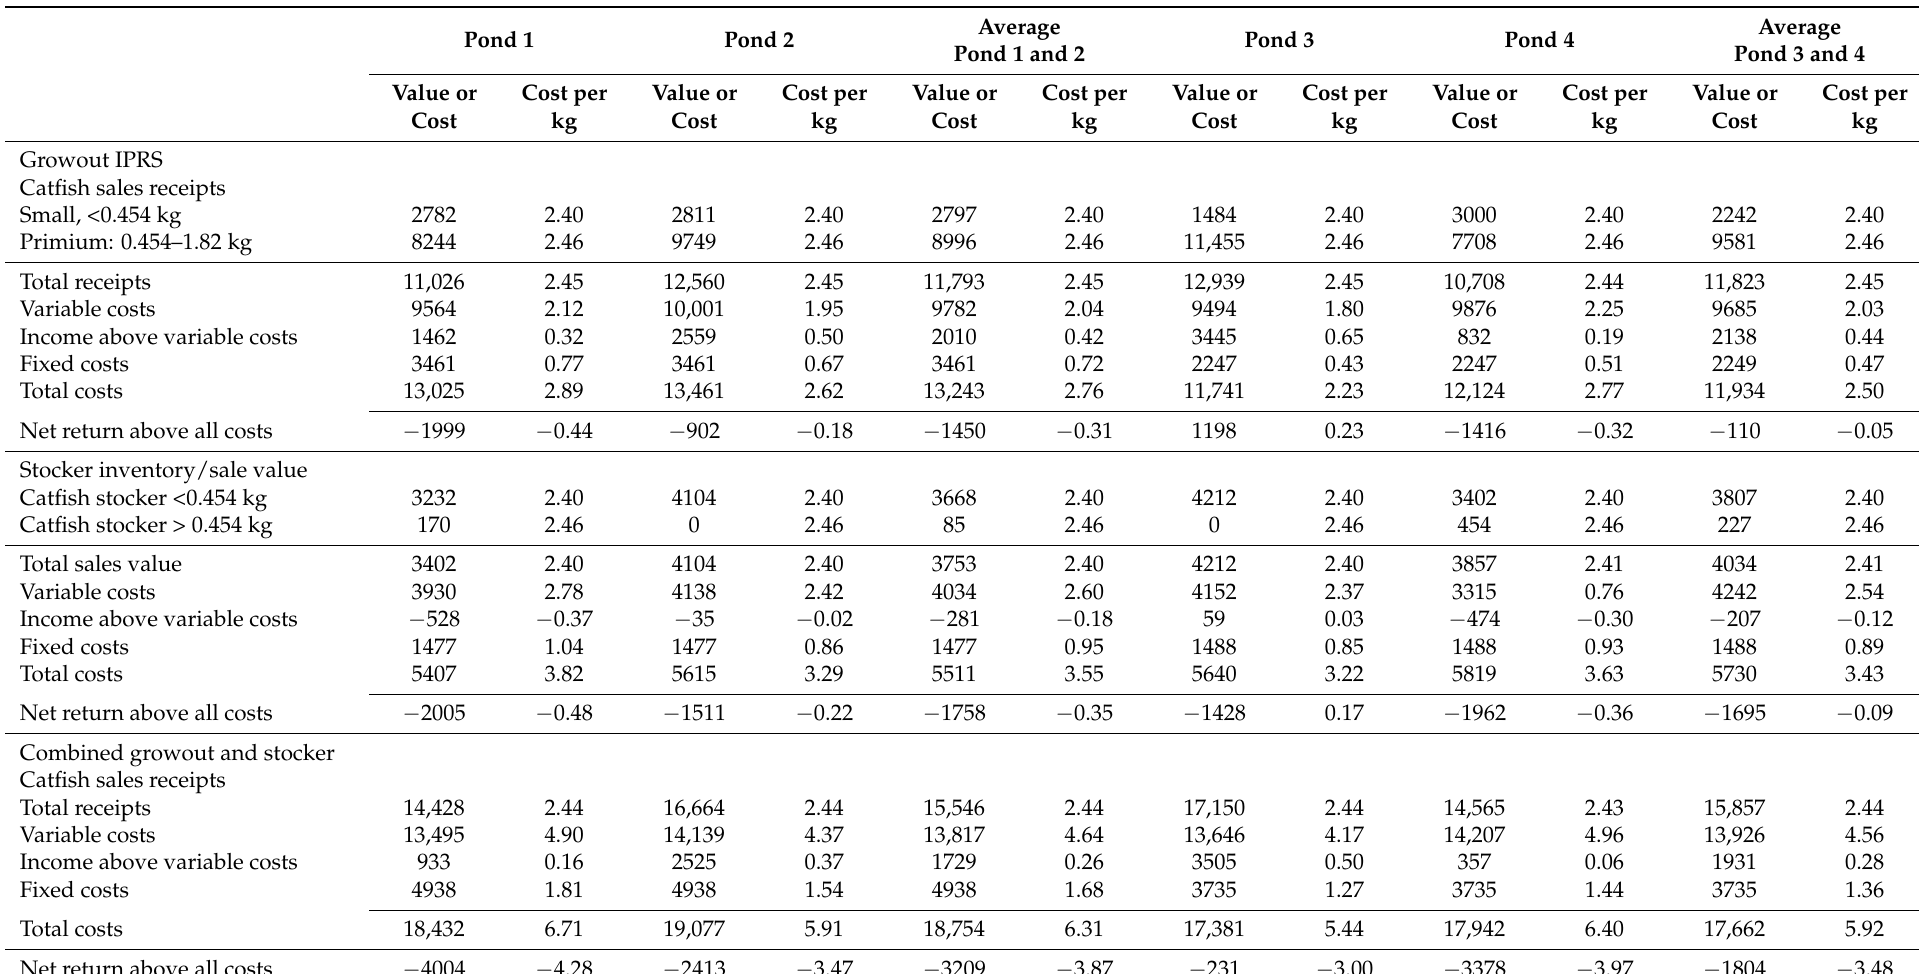
Table 8. Summary enterprise budgets for four in-pond raceway system (IPRS) producing foodsize and stocker hybrid catfish, channel catfish Ictalurus